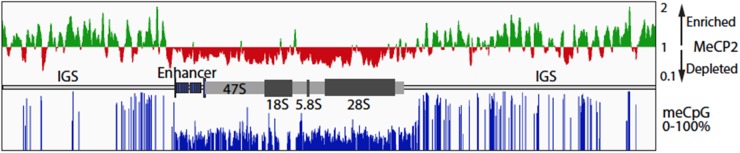
MeCP2 binding at the ribosomal RNA gene locus in the murine forebrain. Public data for MeCP2 ChIP-Seq (GSM1464563, GSM1464564) and WGBS (GSM1173783) from 6-week-old mouse forebrain was realigned to the in silica mouse genome to which a single copy of the mouse rRNA (GenBank BK000964v3) had been added. The upper panel shows the distribution of MeCP2 ChIPped DNA sequence coverage as compared to input DNA sequence coverage. On the vertical scale, regions with a score >1 indicates sequence enrichment and <1 sequence depletion relative the input DNA sequence coverage. MeCP2 is strongly depleted from the enhancer and 47S transcribed region. The lower panel shows the percent methylation at CpG motifs across the whole rRNA gene repeat unit. A diagrammatic representation of the rRNA gene organization is shown between the upper and lower panels. IGS, Intergenic Spacer; 47S, the region transcribed into the 47S primary rRNA precursor; 18, 5.8, and 28S; the regions encoding the mature rRNAs.